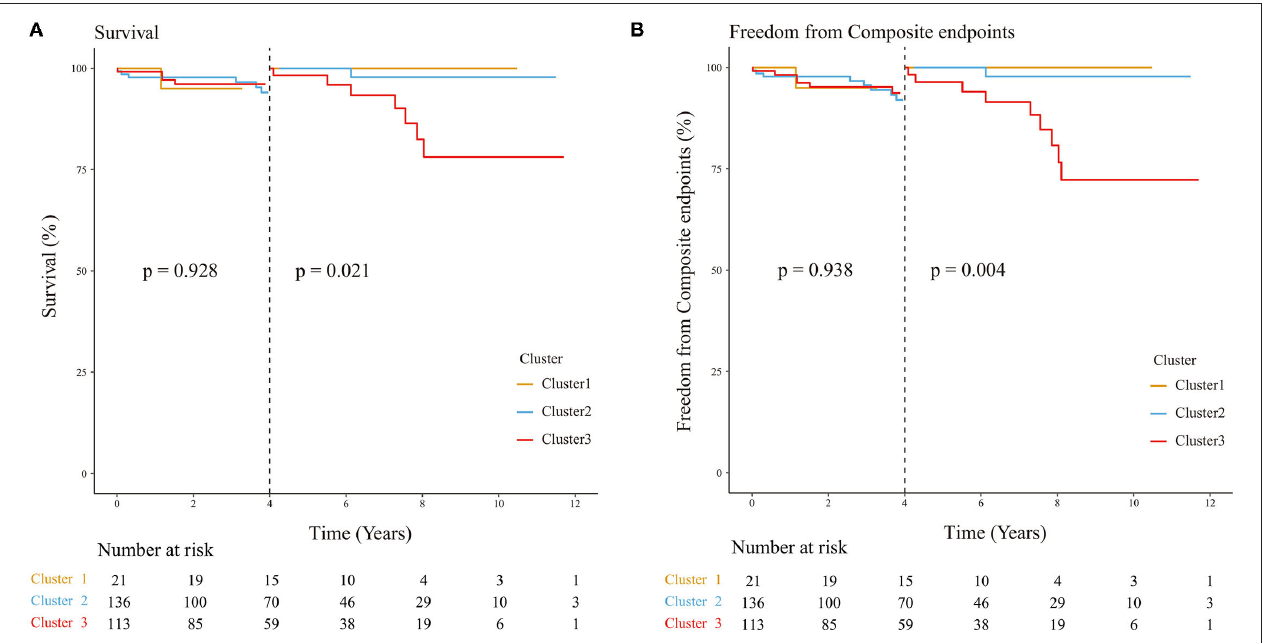
FIGURE 4 | Landmark analysis of three clusters. (A) Landmark analysis for survival rate among three clusters; (B) Freedom from composite endpoints among three clusters. The landmark analyses reveal statistical significance among three clusters ( p = 0.021 for overall survival rate, p = 0.004 for composite endpoints).